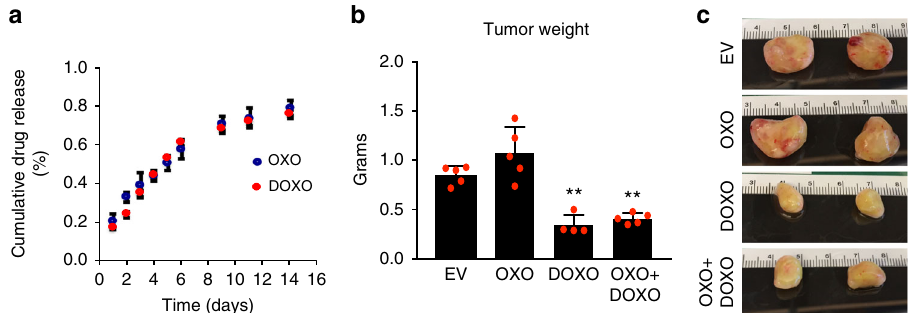
Fig. 1 Treatment with 5 Z -7-Oxozeaenol (OXO) does not reduce growth of established primary tumors. a In vitro release kinetics of OXO and doxorubicin (DOXO) from dual drug-loaded cross-linked multilamellar vesicles (cMLVs). Means ± SD of three measurements are shown. b , c Average tumor weight ( b ) and representative images ( c ) of primary tumors dissected from mice treated with nanoparticles containing empty vehicle (EV), OXO, DOXO, or the combination of both drugs for 30 days. Treatment with nanoparticles was initiated 2 weeks after orthotopically inoculating mice with two million MDA- MB-231 cells. Data are shown as means ± SEM of fi ve mice. Statistical analysis: unpaired two-tailed Student ’ s t test. ** p ≤ 0.01 compared to empty vehicle